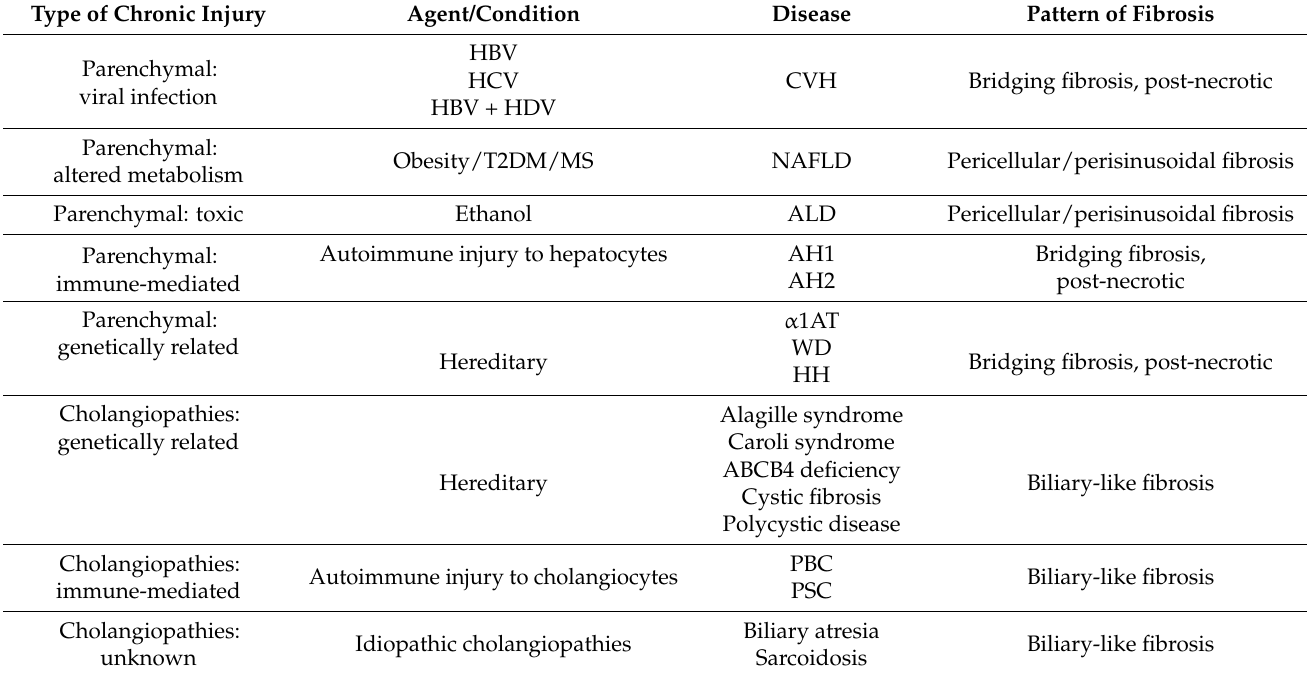
Table 1. Chronic liver diseases in human patients. Major etiological agents/conditions, type of disease and patterns of